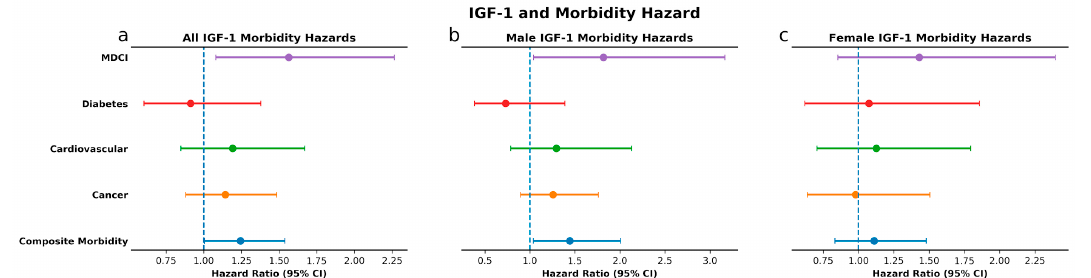
Figure 3. IGF-1 levels and morbidity. Unadjusted survival curves for multiple-domain cognitive impairment (MDCI) ( a . combined cohort; b . males; c . females), diabetes ( d – f ), cardiovascular disease ( g – i ), cancer ( j – l ), and composite incident morbidity ( m – o ) in individuals with high and low levels of IGF-1.